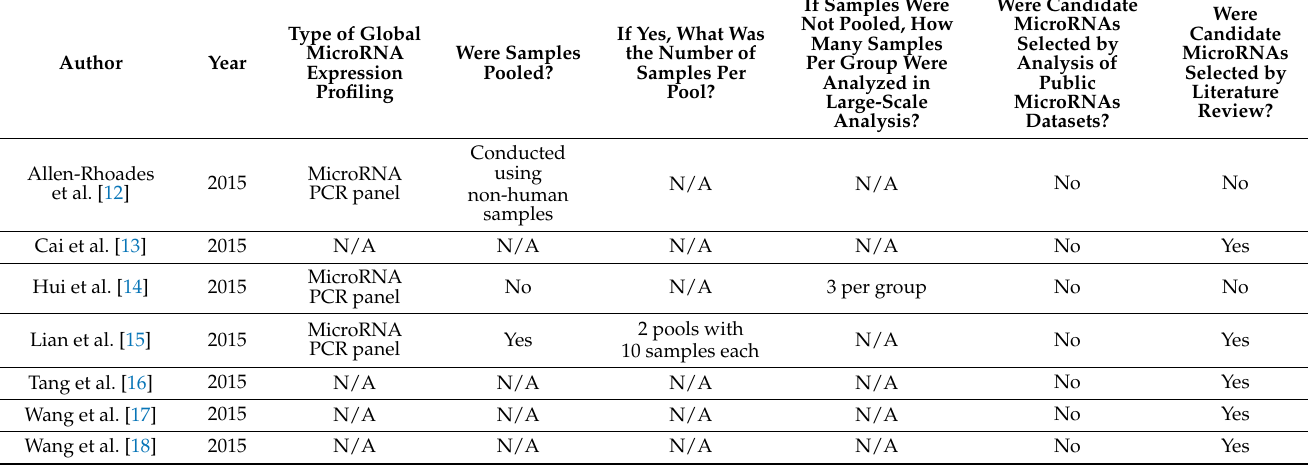
Table 1. MicroRNA candidate selection methods found in the included